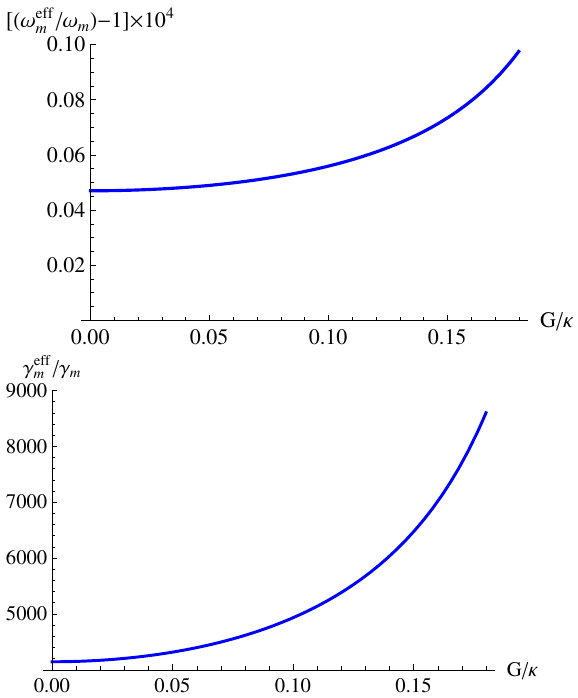
Figure 5. Variations of the effective mechanical frequency ω ef f m ( top ) and the effective mechanical damping rate γ ef f m ( bottom ) as a function of the parametric gain G normalized to κ . Parameters: ℘ = 0.1 mW, θ =